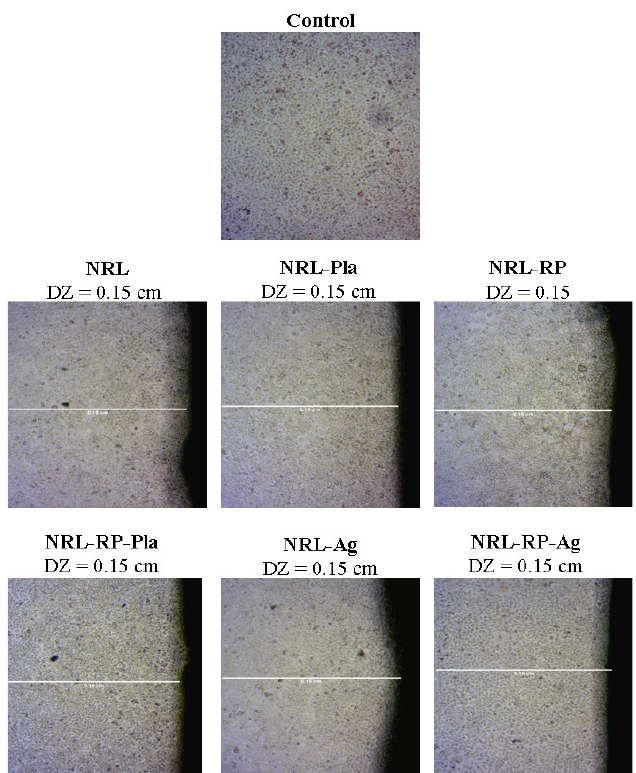
Figure 6. Overlay assay with L929 cells. Visualization on inverted microscope (magnification of 40 ×). Measurements of discoloration zones (DZ) carried out on ImageJ, with scale calibration (0.1 cm).